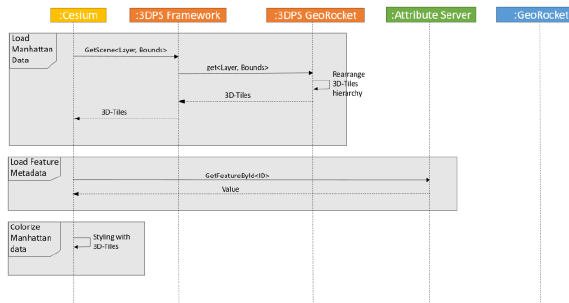
Figure 5. The data flow from GeoRocket to the visualized 3D Tiles, which are requested via the 3D Portrayal Service queries.